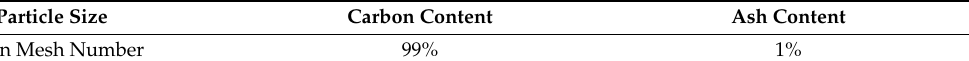
Table 2. Characteristics of the graphite.